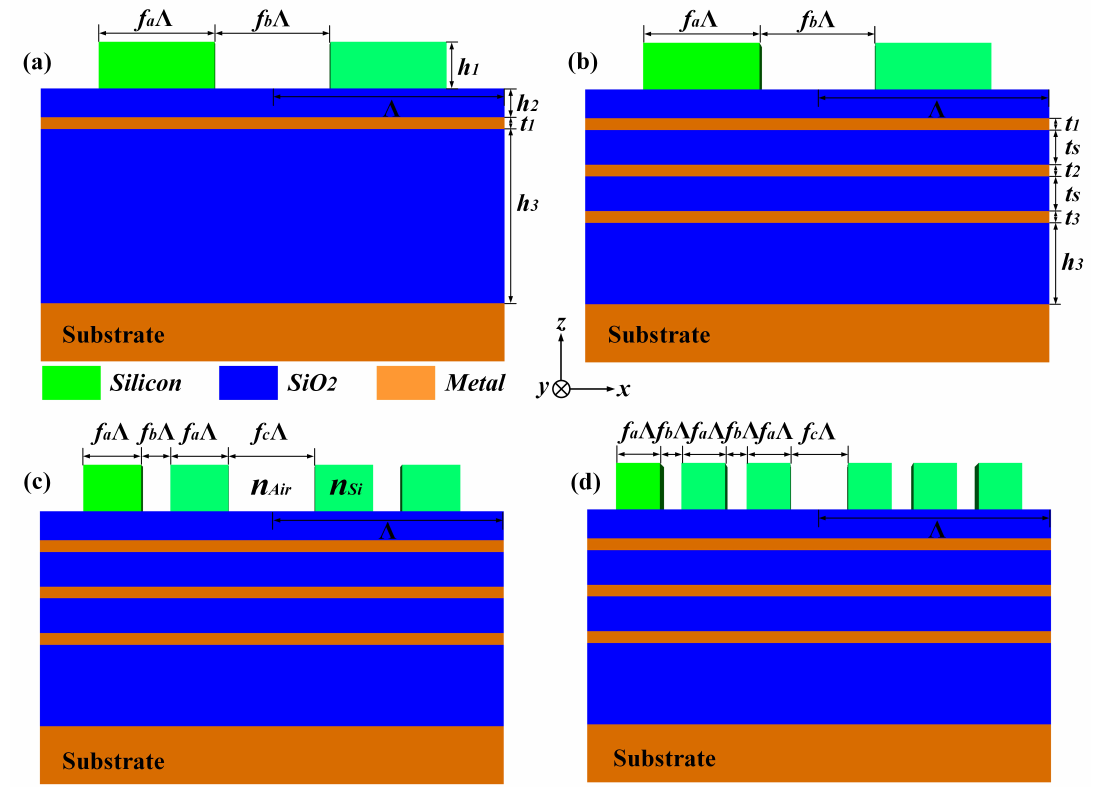
Figure 1. Schematic diagram of the ordinary silicon grating based on SiO 2 -metal-sandwich substrate consists of ( a ) single metal layer; ( b ) three Fe layers; schematic diagram of the proposed ( c ) two-part-period grating and ( d ) three-part-period grating based on SFSS.